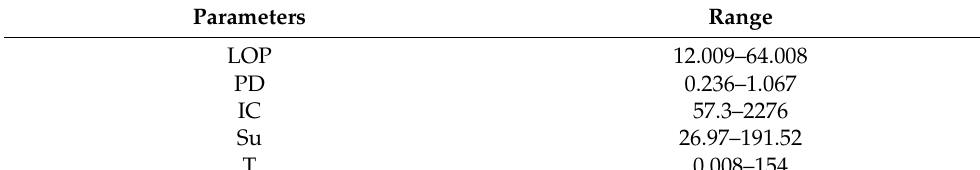
Table 1. The input parameters range.